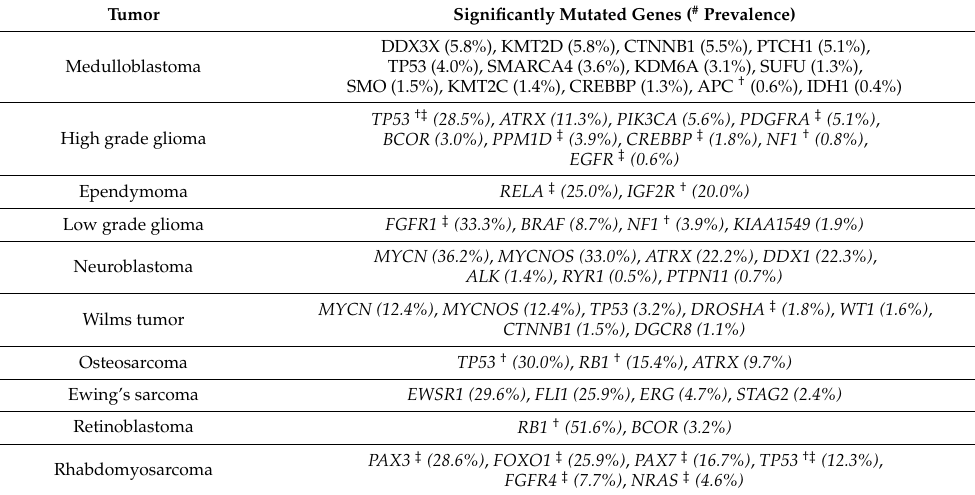
Table 3. Somatic and germline mutated genes of selected pediatric